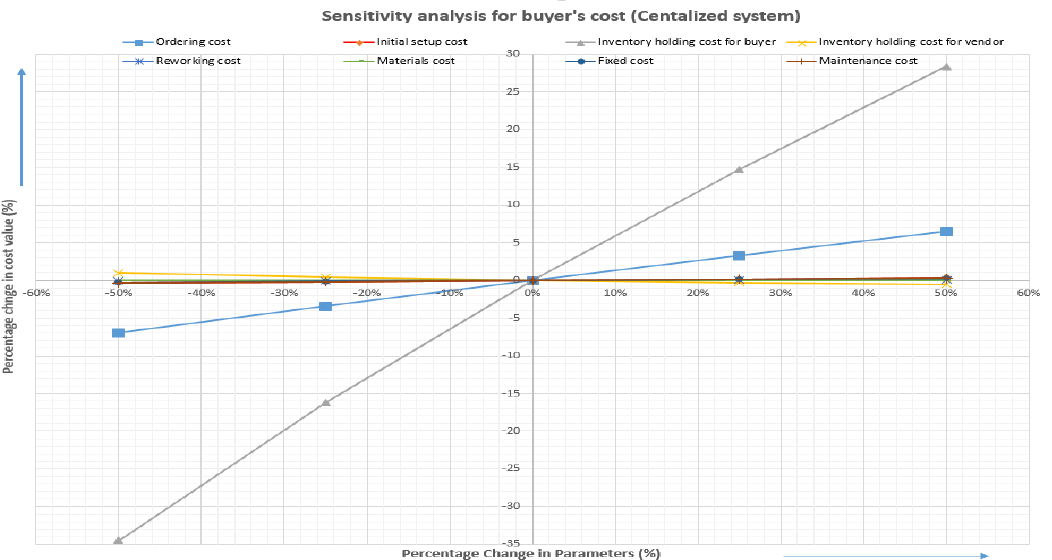
Figure 7. Sensitivity analysis: total cost versus change in parameters under centralized